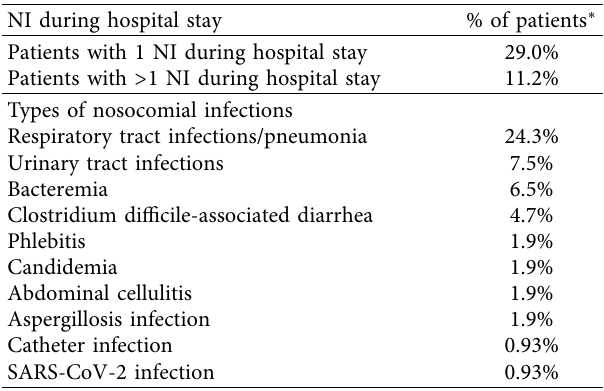
Table 4: Types and frequency of nosocomial infections during the hospital stay.